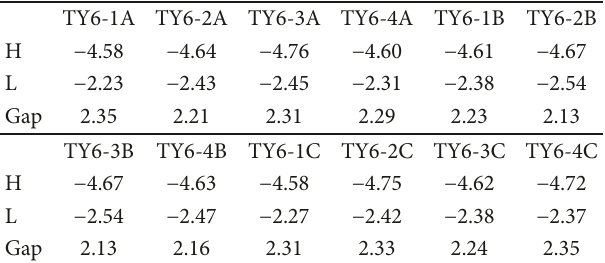
Table 11: Frontier molecular orbital energies and energy gaps (eV) of